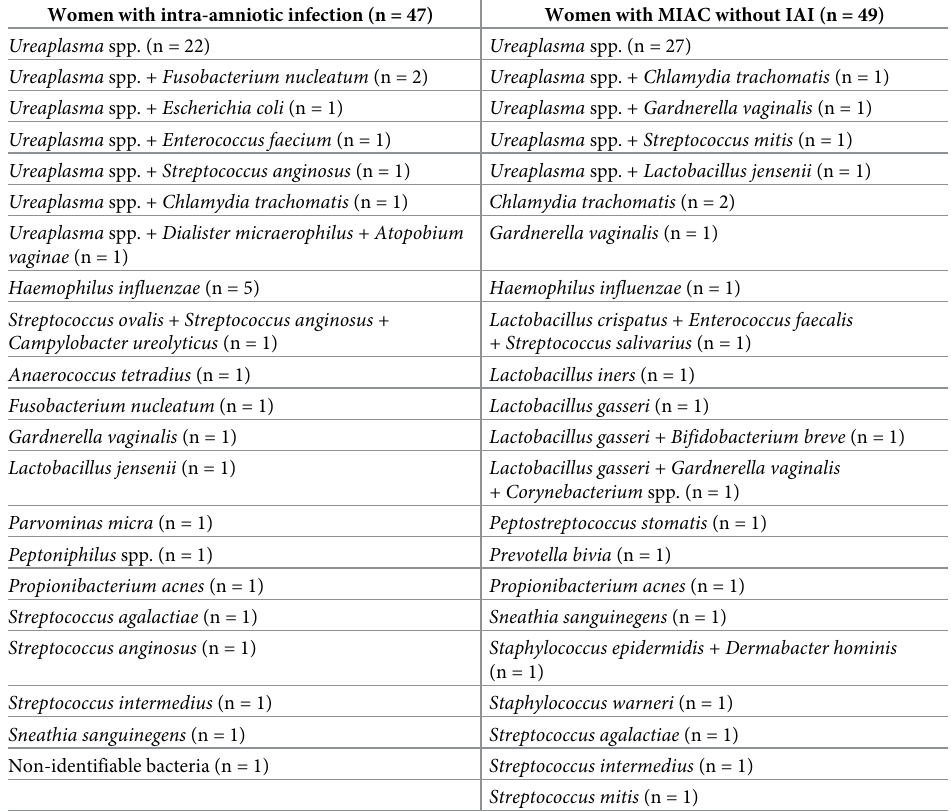
Non-identifiable bacteria (n =